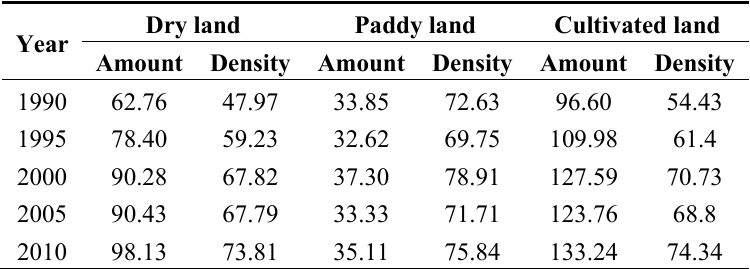
Figure 3. Changes in CR